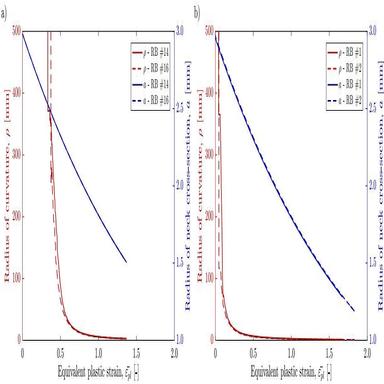
Evolution of the neck geometry (minimum cross-sectional radius (a) and radius of curvature of the osculating circle (ρ)) vs. equivalent plastic strain: (a) stainless steel 304L; (b) copper C110.